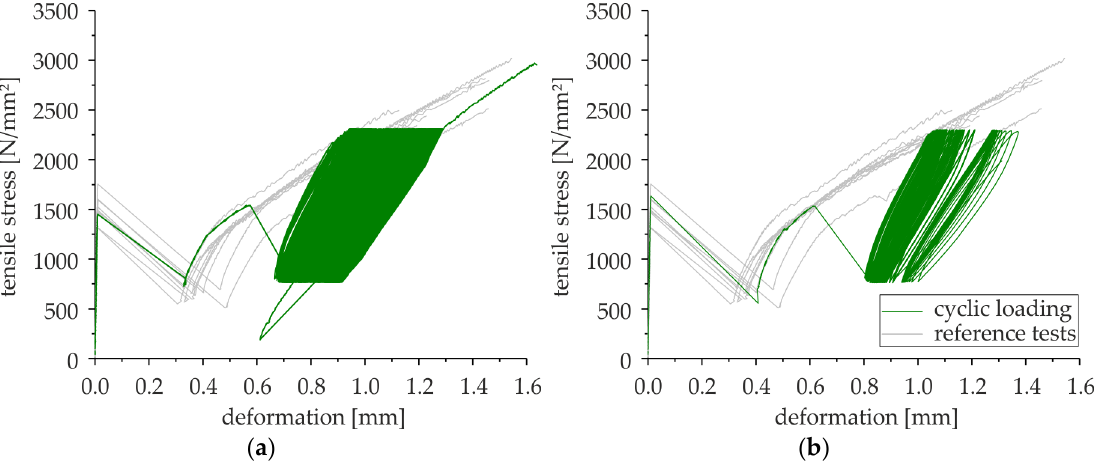
Figure 5. Cyclic stress–deformation curves (here: anchorage length = 3 a ; σ min / σ max = 30%/90%): ( a ) non-failed specimen; ( b ) failed specimen (load cycles: 57733).